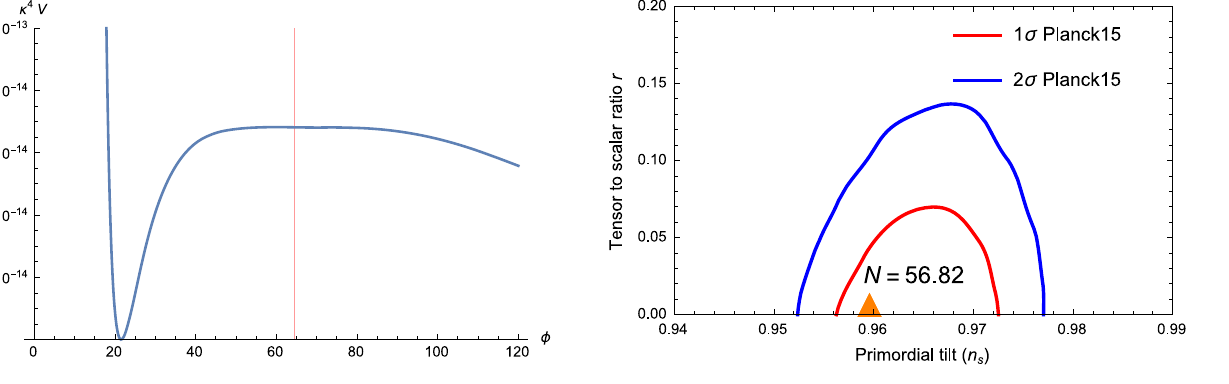
Fig. 7 A plot of the predictions for a scalar potential in Eq. (70) shown in Table 2, in the n s – r Planck ’15 results for TT,TE,EE,+lowP and assuming (cid:9) CDM +